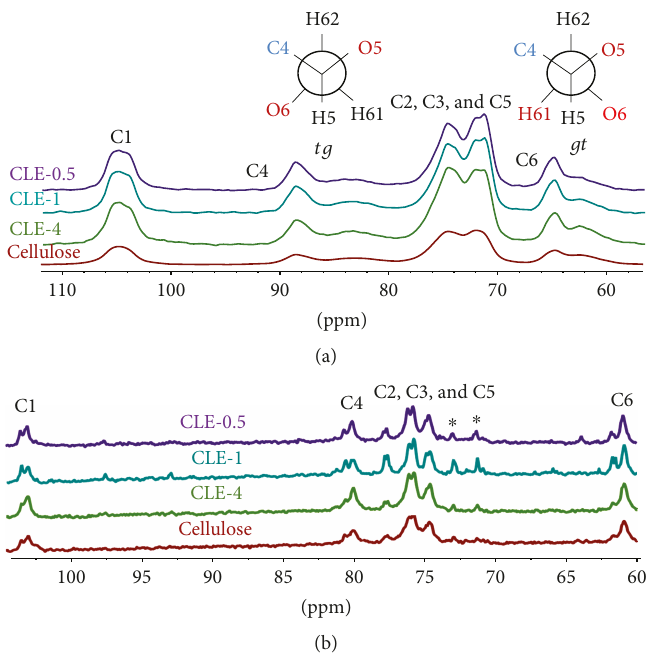
Figure 2: 13 C NMR spectra of cellulose and its cross-linked forms: (a) solid 13 C CP-MAS NMR spectra at 295K and (b) solution NMR spectra in a IL-DMSO- d solution system at 353K where the asterisk ( ∗ ) denotes signatures due to the EP linker 6